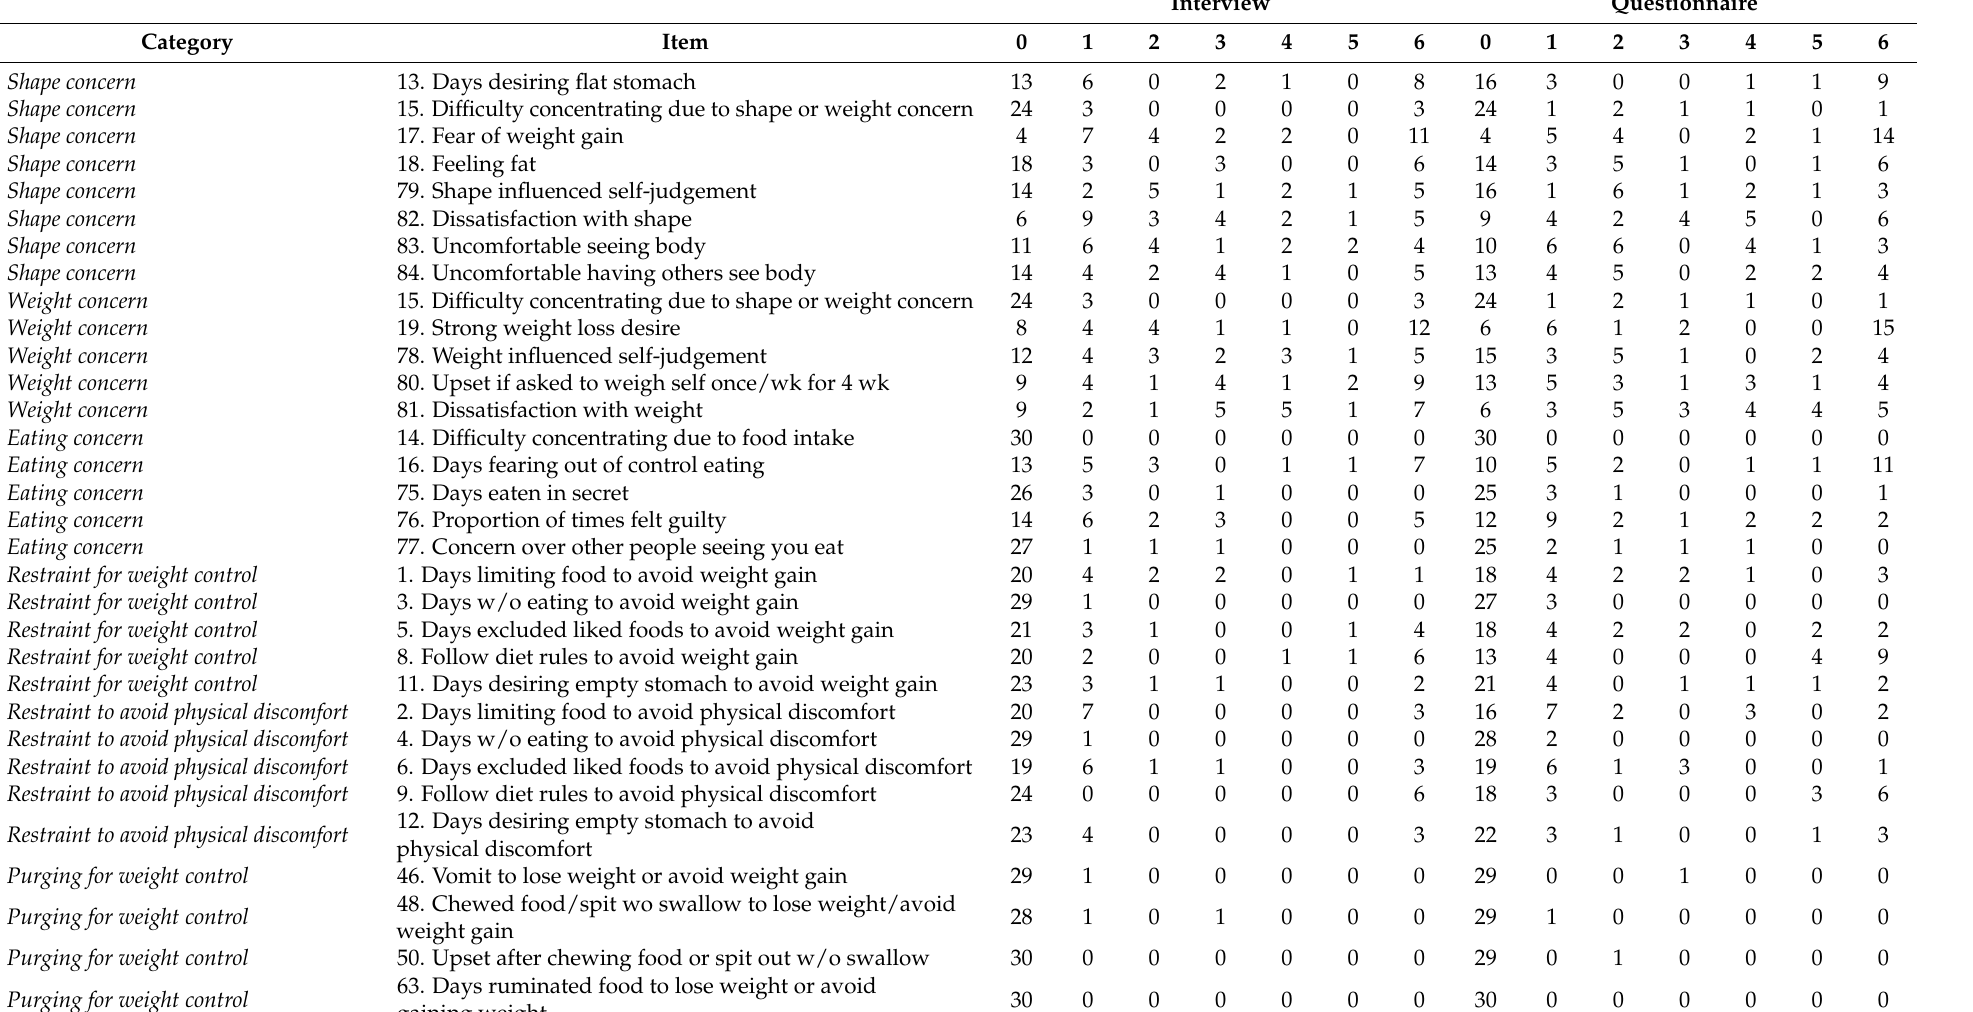
Table 1. Frequency of ordinal responses to the interview and questionnaire a